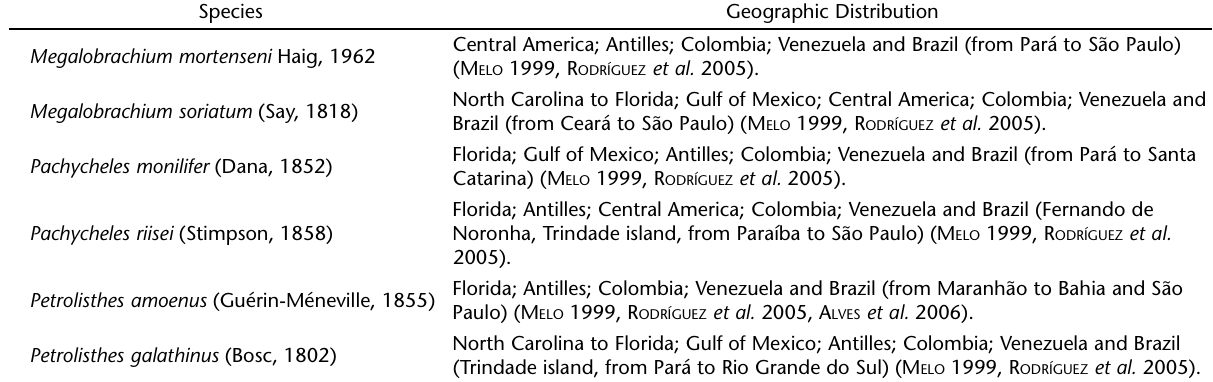
Table II. Western Atlantic geographic distribution of the porcellanid species obtained from February 2004 to January 2006 off Vitória Island.